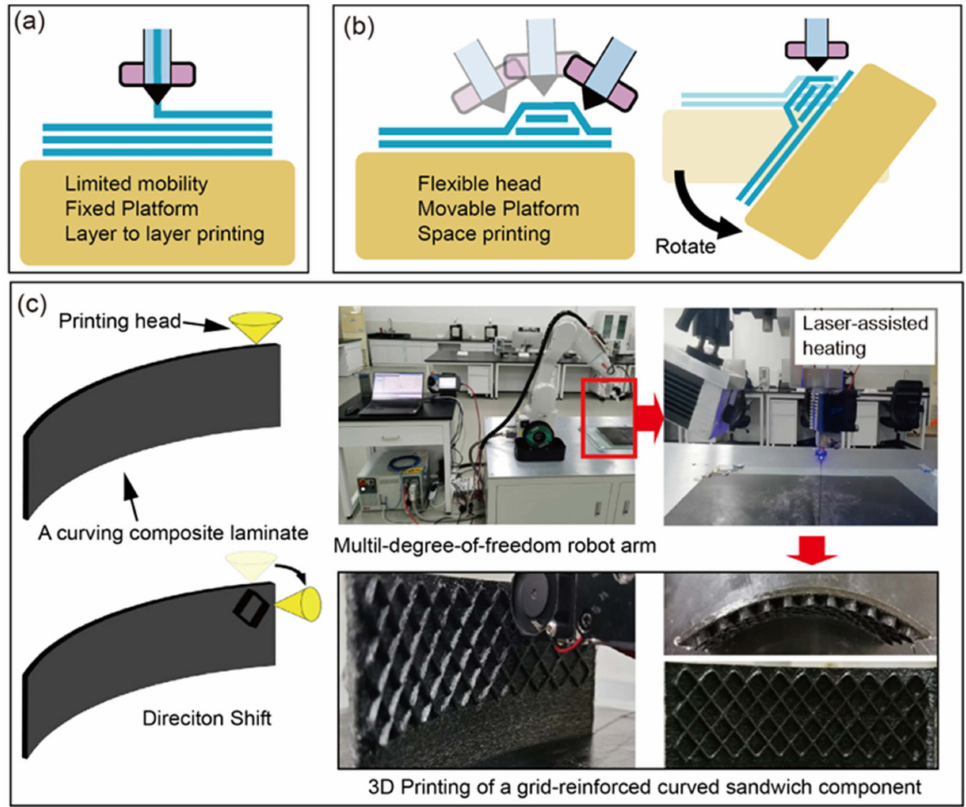
Figure 14. Additive manufacturing. ( a ) Traditional additive manufacturing by layer to layer; ( b ) Multi-degree-of-freedom additive manufacturing; and ( c ) Multi-degree-of-freedom additive manufacturing of a grid-reinforced curved sandwich component with laser-assisted heating